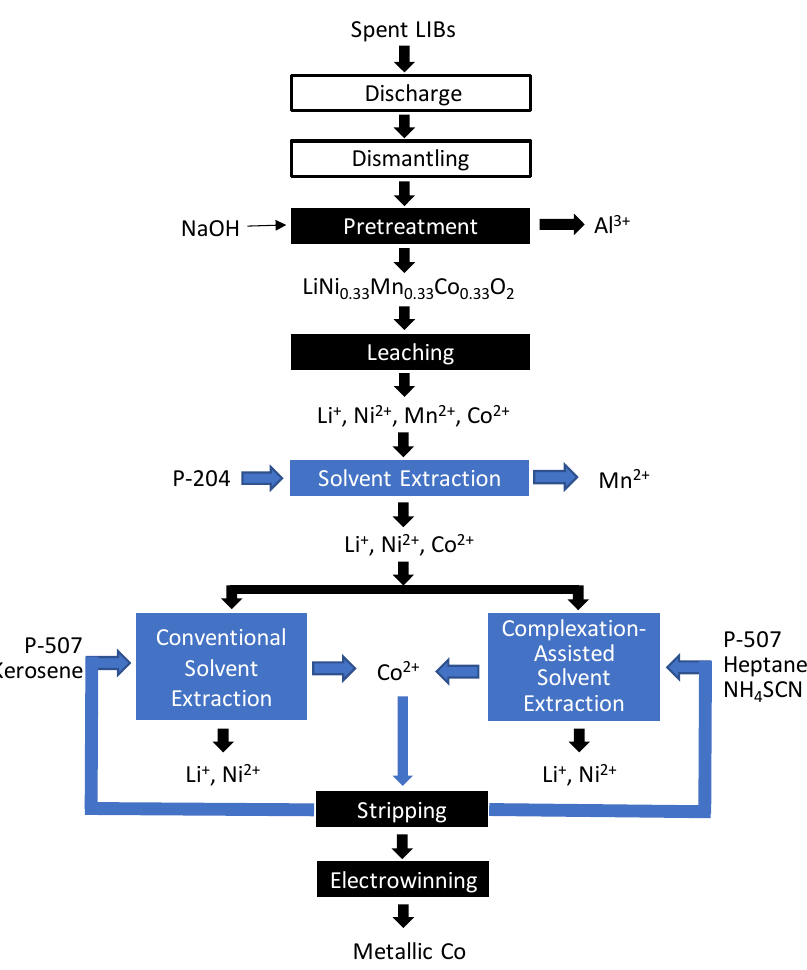
Figure 1. Flow sheet for recovering cobalt from the cathode materials of spent LIBs. Blue blocks represent organic phase and black blocks represent aqueous phase.